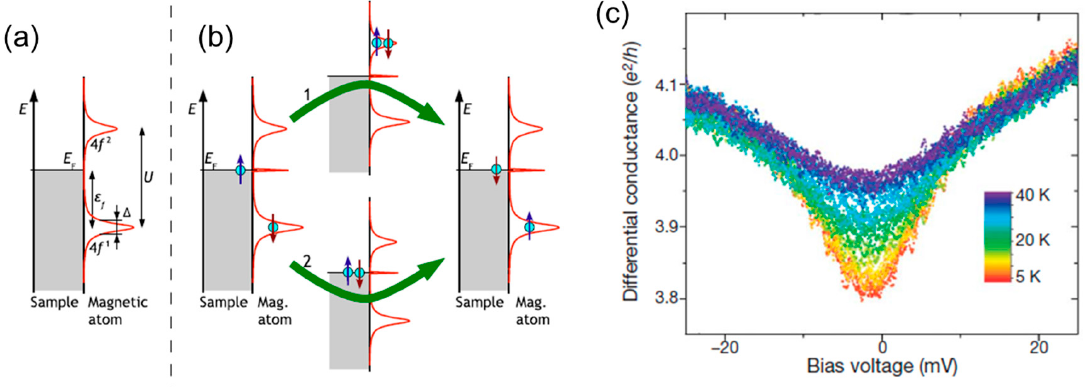
Figure 13. ( a ) Energy-dependent density of state (DOS) for the system where a single magnetic atom adsorbs on a metal sample. ( b ) The spin-flip process induced by the interaction between of the singly occupied state and bulk electron of opposite spin. The spin-flip process (process 1 and 2) form the Kondo resonance around the Fermi energy ( c ) Differential conductance curves for the Co atomic junction measured at different temperatures. Reproduced with permission from [59] copyright Nature Publishing Group